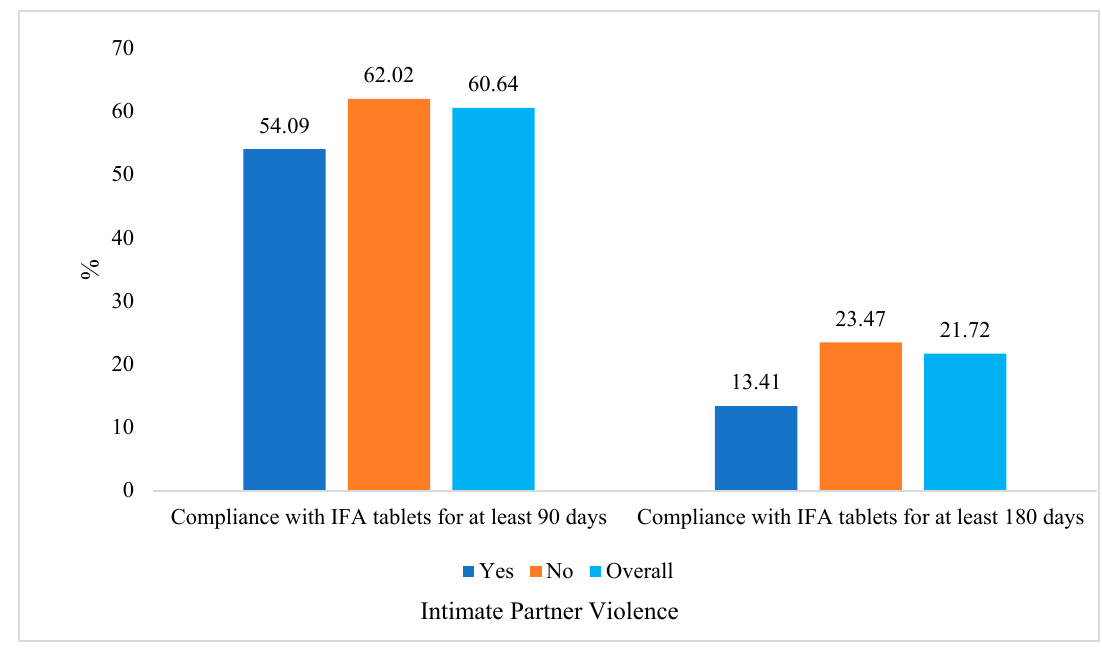
Figure 1. Distribution of iron–folic acid (IFA) compliance. Table 2. Factors associated with iron–folic acid compliance for at least 90 days and 180